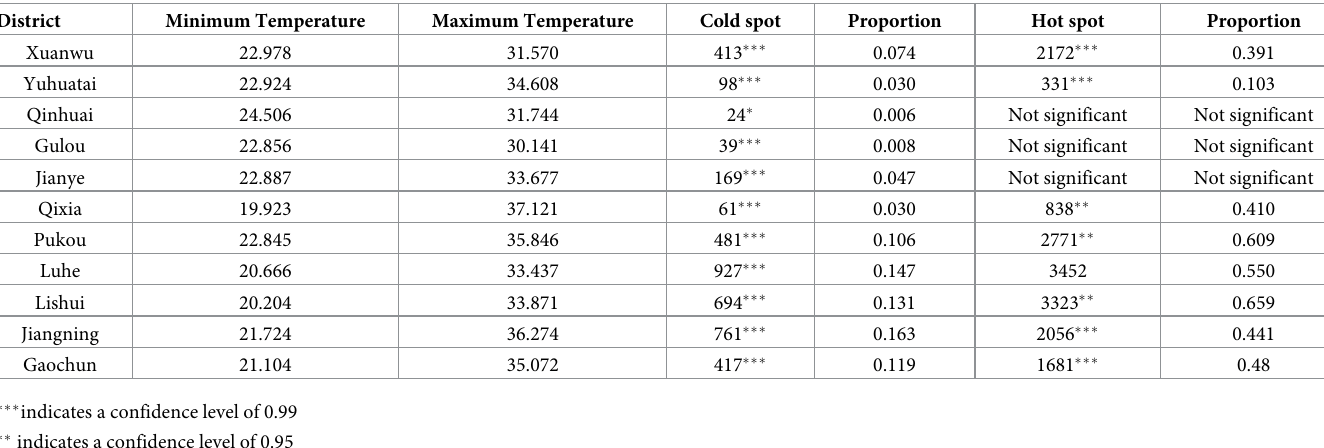
Table 3. Statistics of LST in each